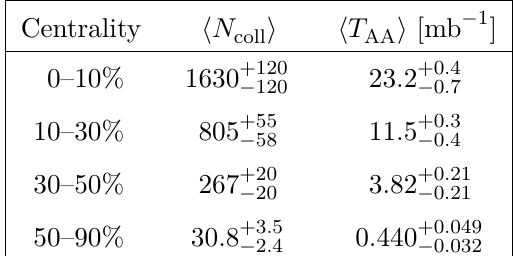
√ = 5 . 02 TeV PbPb s NN